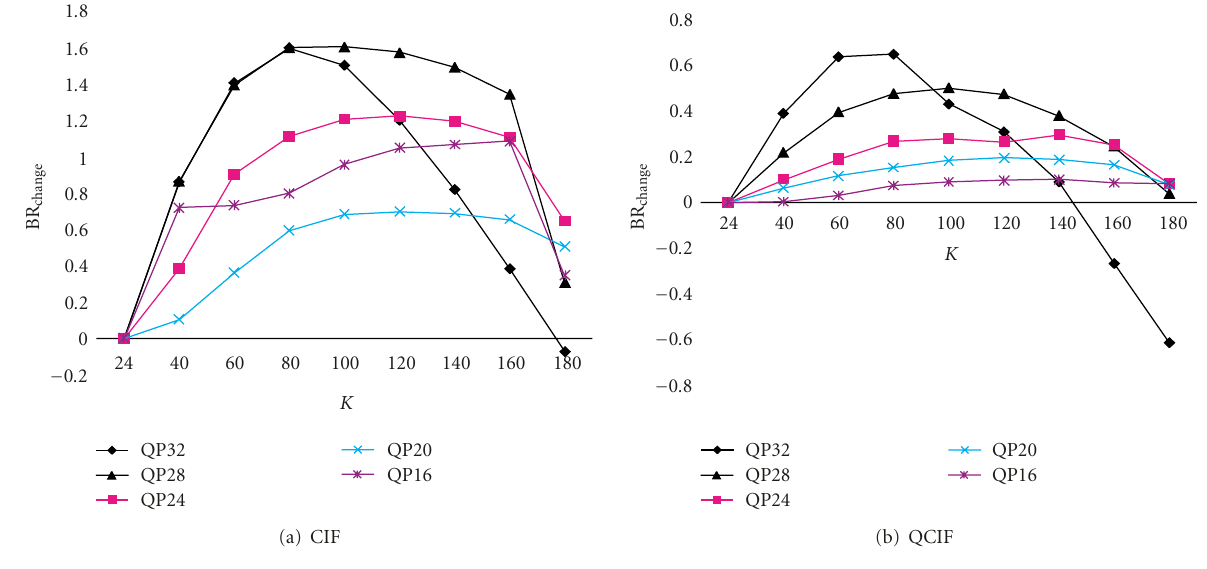
Figure 8: Bit rate change averaged over 11 sequences.